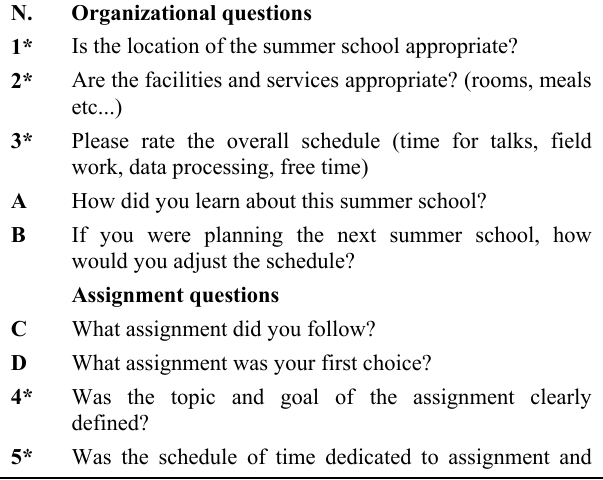
Table 4. Questions in feedback form. Values for column “N.” are enumerated (1-11) with asterisk for ordinal scale answers, or letters (A-D) for nominal scale and remaining (E-I) for free text answers.